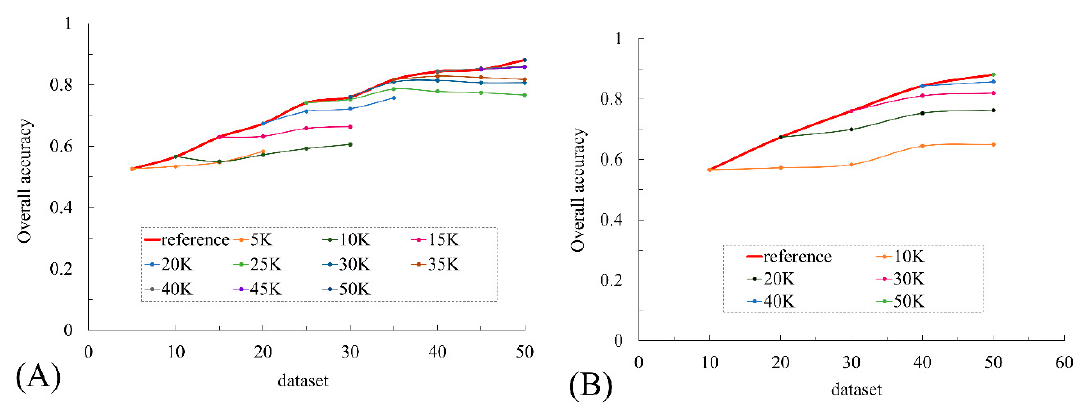
Figure 7. Relation between datasets and the overall accuracy for automatic training. ( A ) Additional learning for every 5000 images, ( B ) additional learning for every 10,000 images.